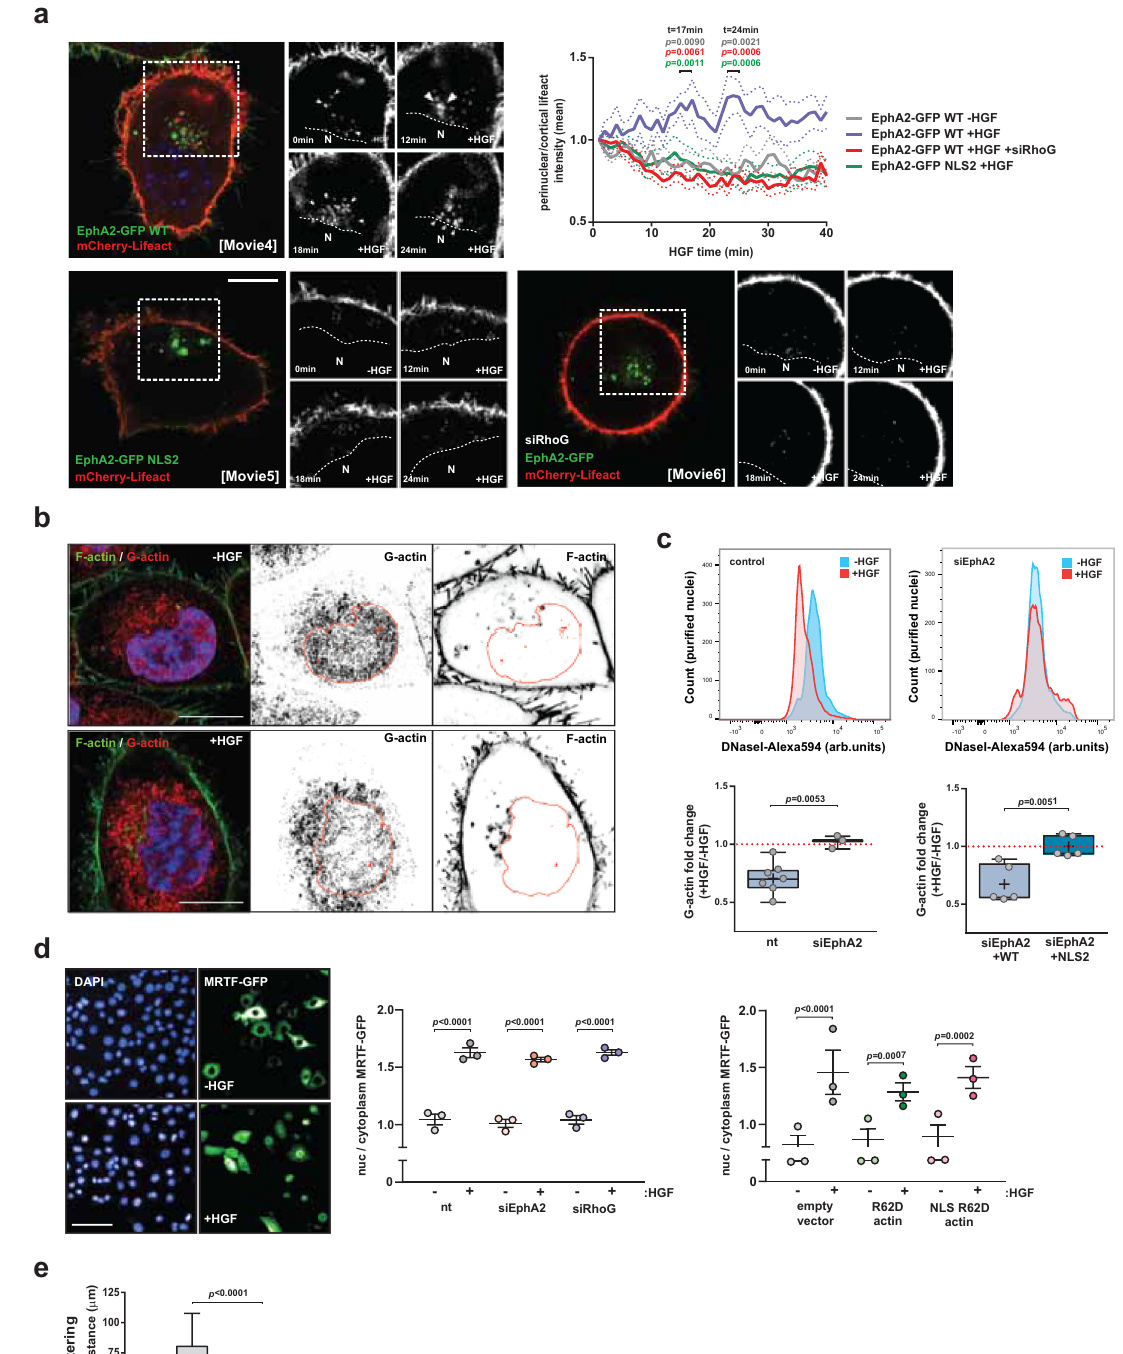
DNaseI-Alexa594 (arb.units)